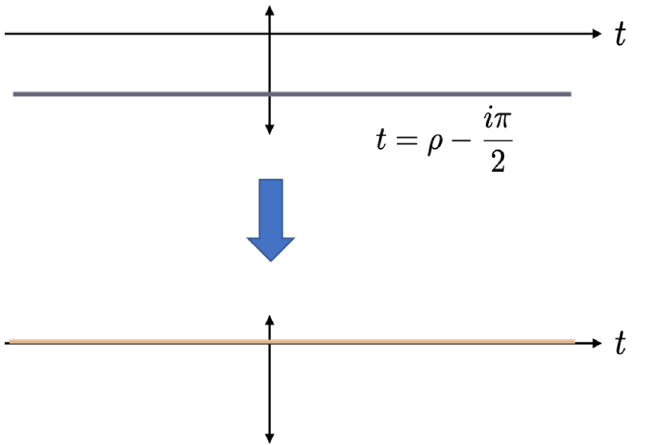
Figure 10 . The change of complex time contour to go from the global de Sitter geometry in Lorentzian nearly-dS 2 in ( (cid:0) ; +) signature to the double trumpet geometry in Euclidean nearly- AdS 2 in ( (cid:0) ; (cid:0) ) signature. The global de Sitter geometry is the only classical solution to nearly-dS 2 JT